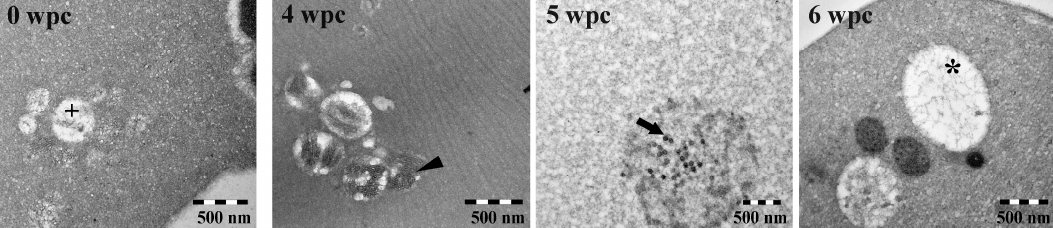
Figure 4. Transmission electron microscopy (TEM) of blood cells. PRV-infected red blood cells sampled at 0 (negative control), 4, 5 and 6 wpc show small empty vesicles (cross), lamellar structures (arrowhead), reovirus-like particles (arrow) and large empty inclusions (star). 3.6. μ NS Protein Expression in Individual Fish Correlate with viral RNA only during the Acute Phase of 372